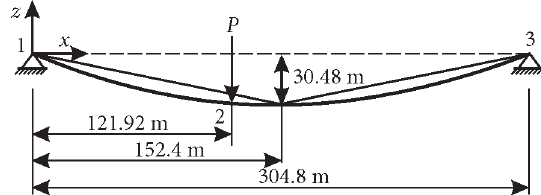
Fig. 5. Isolated cable under